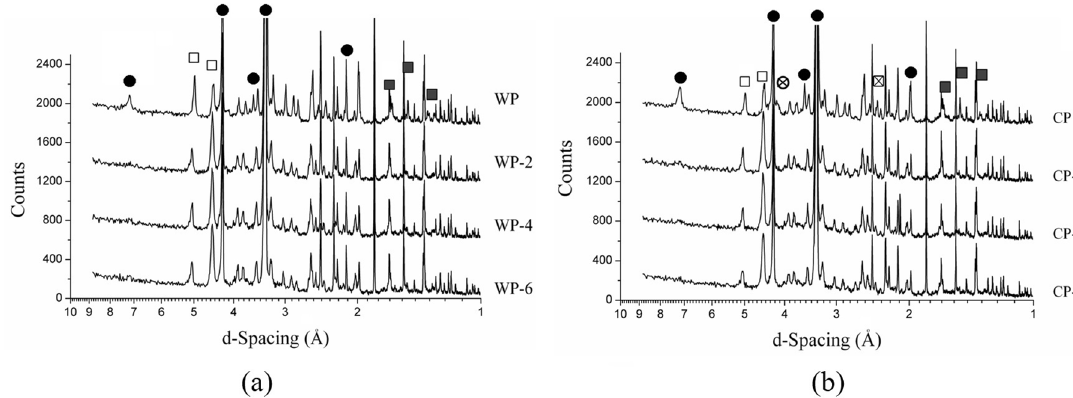
Figure 2. Comparative X-ray diffractograms of (a) white phyllite (WP) (b) cream phyllite (CP); and the calcination products at 850oC for 2, 4 and 6 h, where (●) are the main kaolinite peaks; (□) shows partial dehydroxylation of muscovite 2M disorder of muscovite and ( ) shows goethite transformed into hematite ( ). The other peaks shown are due to